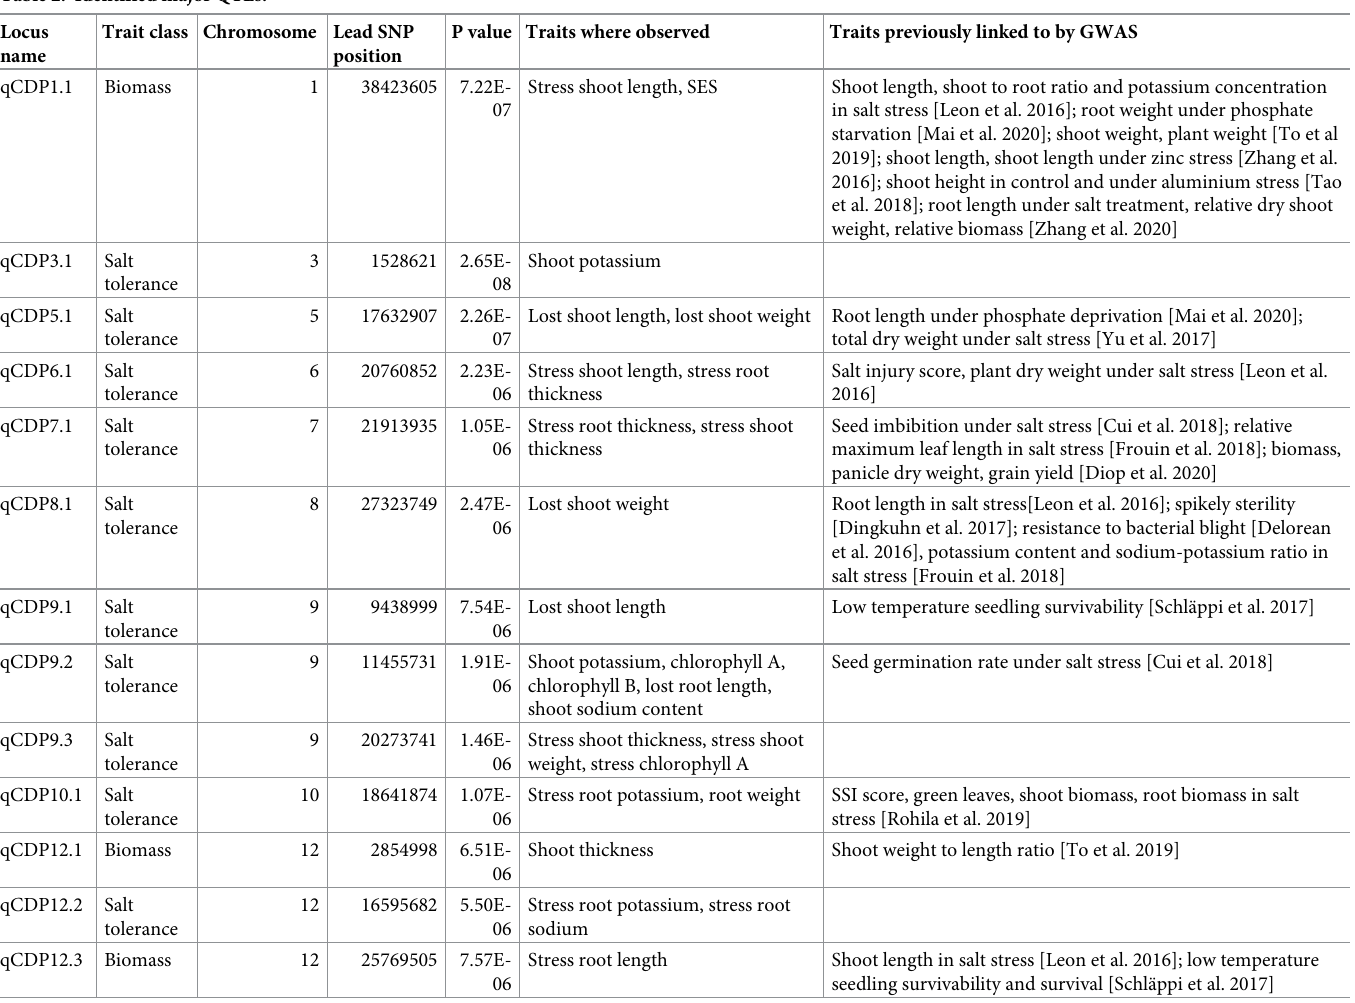
Table 2. Identified major